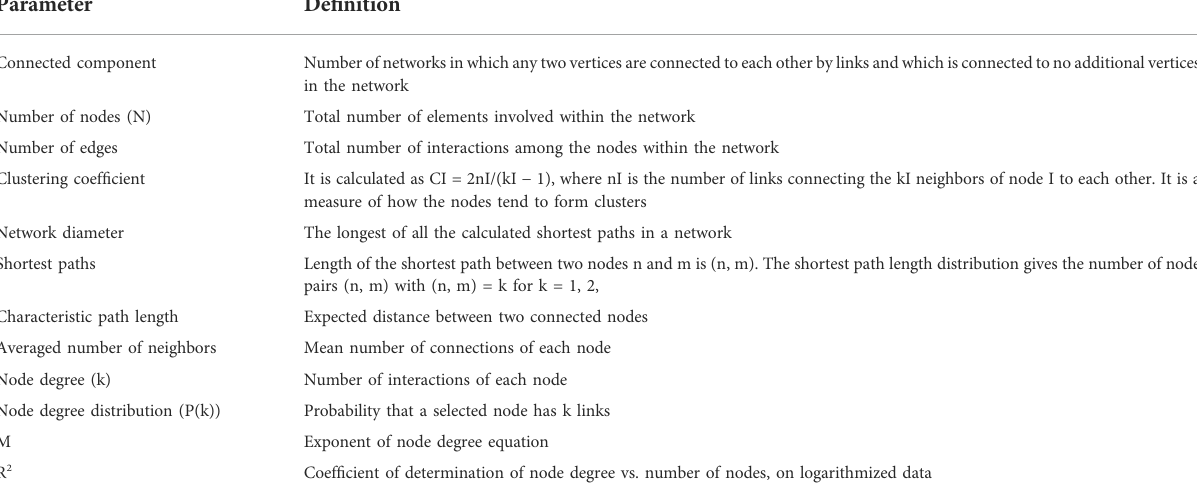
TABLE 1 Topological parameters of the network. The table shows the de fi nitions of the main topological parameters assessed in this study.